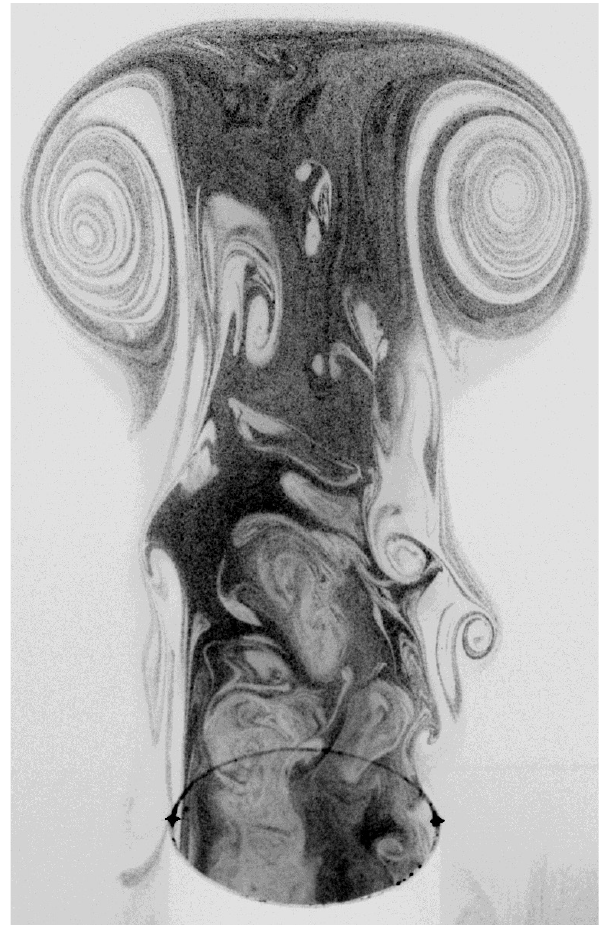
Figure 5. A cross section of a thermal plume generated in a labo- ratory with use of a humidifier as a buoyancy source. Distribution of condensed water is shown by gray tones (courtesy: Anna Gorska and Szymon